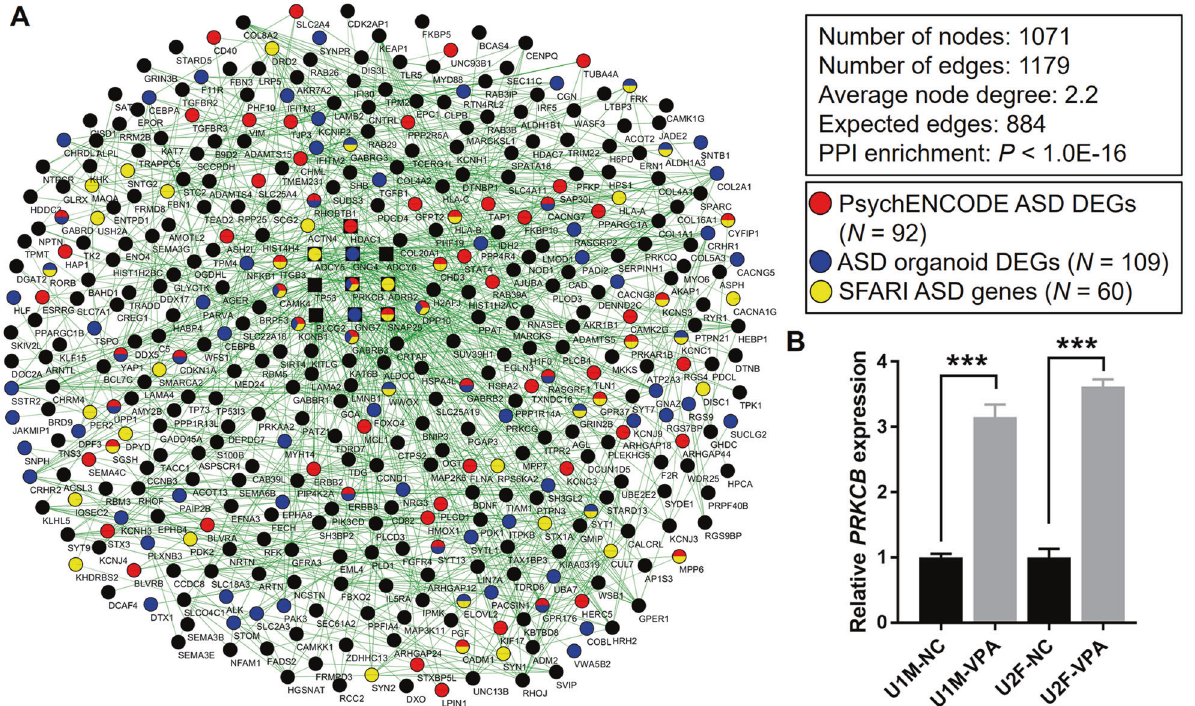
Fig. 3 PPI network for 1241 shared VPA-induced DEGs between U1M and U2F hFOs. A The colors of nodes indicate different ASD- associated gene sets. The number of ASD-associated genes in the PPI network is also indicated. The top ten hub nodes ranked by connectivity degree in the PPI network are shown in the rectangle. Nodes that don ’ t connect with the hub nodes are not shown. The width of edges represents the PPI con fi dence score. B RT-qPCR was used to test PRKCB expression in the VPA-exposed and control hFOs. PRKCB expression in the control group was normalized to 1. Data were shown as Mean ± SEM (organoids N = 7 from two batches). Two-tailed t -test, *** P <